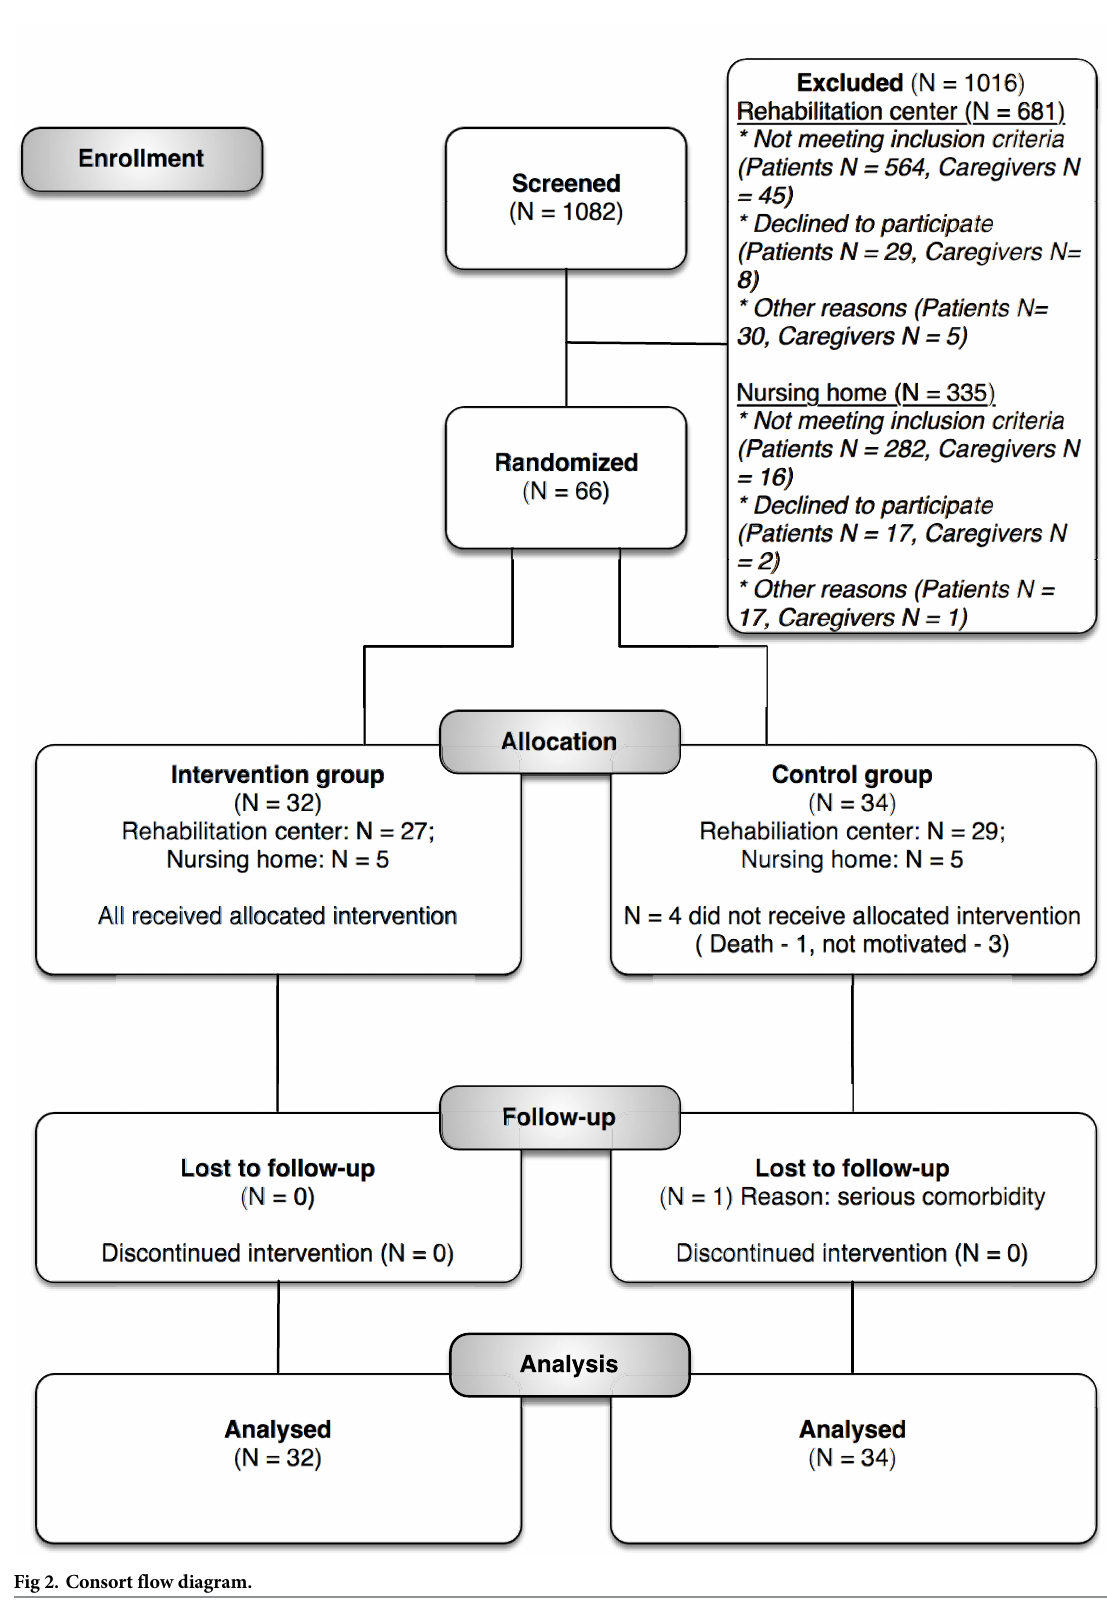
Fig 2. Consort flow diagram.